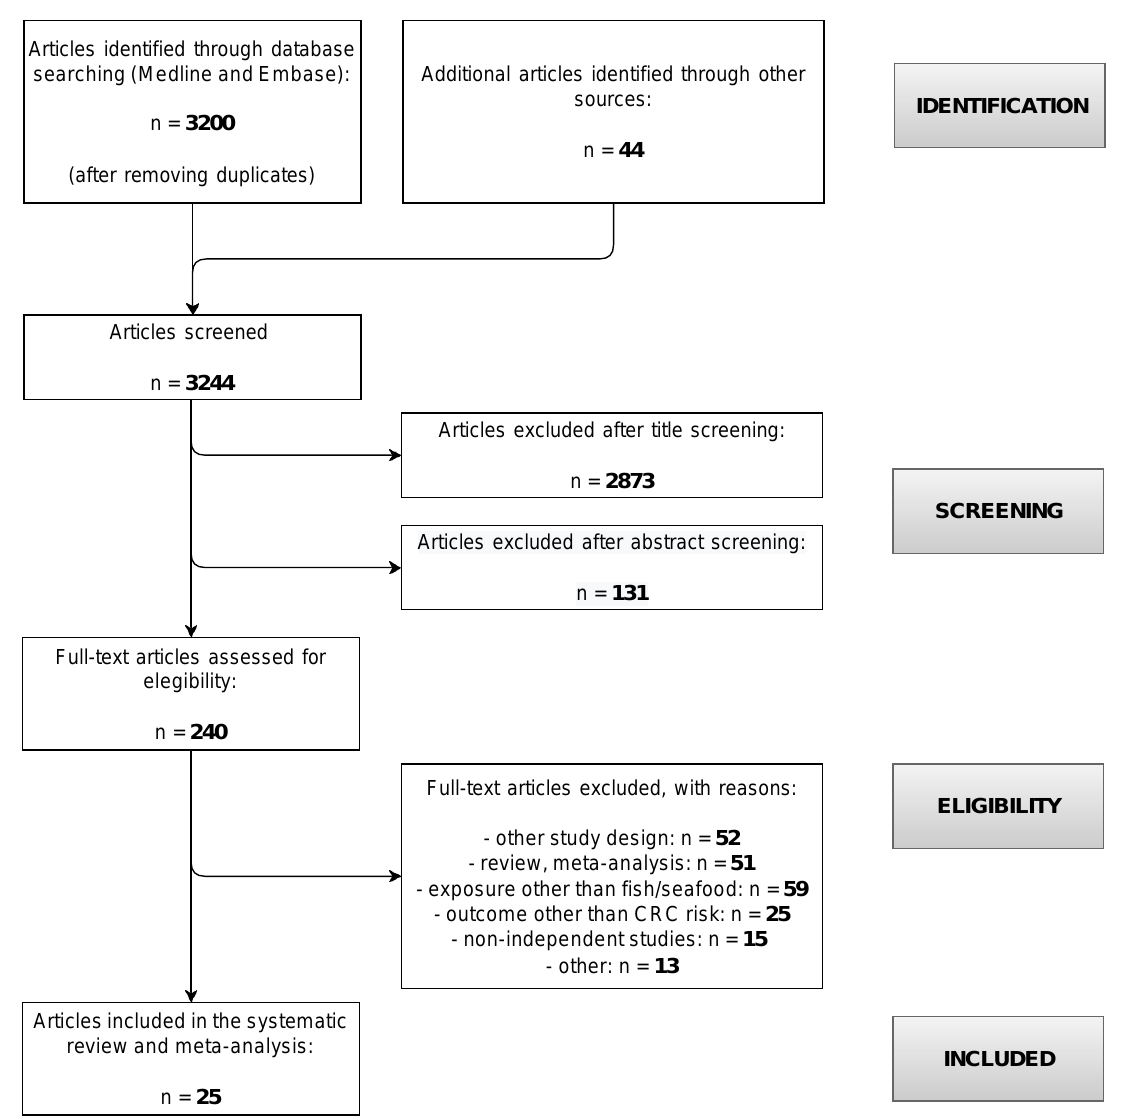
Figure 1. Flow-chart for the selection of articles included in the systematic review and meta-analysis on the association between fish consumption and colorectal cancer